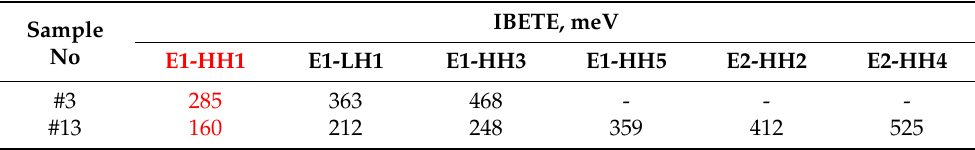
Table 2. The energy of the allowed electronic transition between the conduction and valence sub- bands for different samples #3 and #13 at room temperature. The fundamental electronic transition energy for samples #3 and #13 is represented by the red